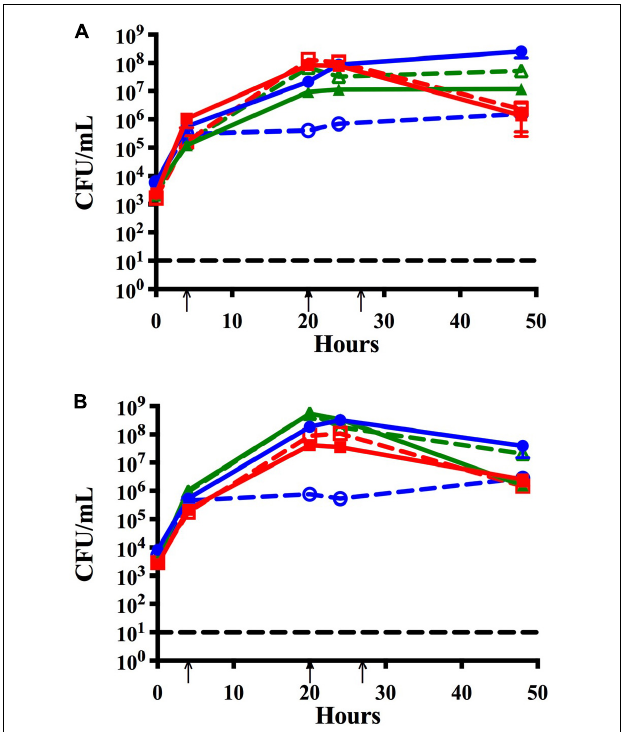
FIGURE 3 | Time course assay to assess the effects of lower seeding concentrations and address strain specificity by analyzing trends of co-infection isolates. Bacteria seeded simultaneously at a lower concentration ( ∼ 10 5 CFU per mL) and maintained with media changes (black arrows) for 48 h in monomicrobial (dashed) or triple species (solid) biofilms. Each symbol and error bar represent the mean CFU per mL and standard deviation (SD) of biofilms at the respective time point. Data presented are from three independent assays with a minimum of two biologic replicates per assay. Black dashed line indicates the limit of CFU detection. (A) NTHi86-028 NP (blue), M. catarrhalis 7169 (green), and S. pneumoniae EF3030 (red) monomicrobial and triple species biofilms. (B) NTHi 11-01-125 (blue), M. catarrhalis 11-01-125 (green) and S. pneumoniae 11-01-125 (red) monomicrobial and triple species biofilms.